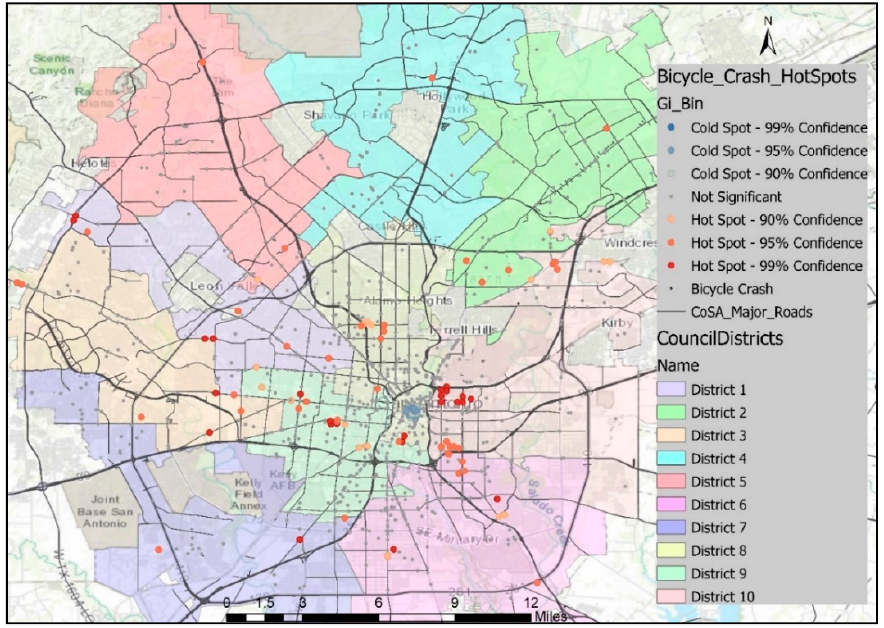
Figure 3. Hot and cold spots of bicycle crashes in San Antonio based on crash severity.